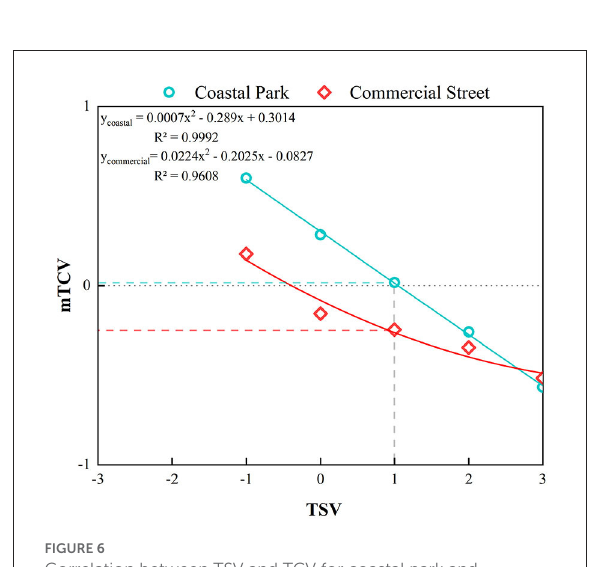
FIGURE6 Correlation between TSV and TCV for coastal park and commercial